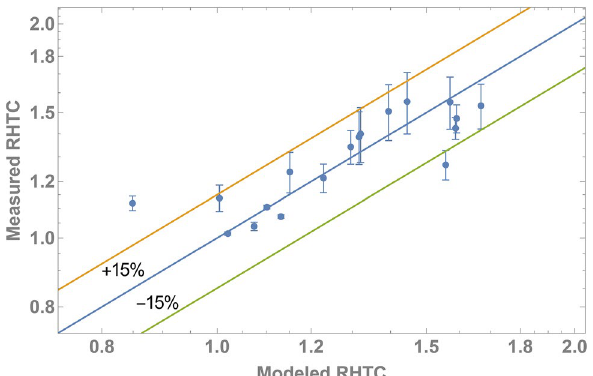
Figure 10. There is good agreement between the measured RTHC (Figs. 6b and 8b) and the modeled RHTC using Eq. (3) for all tested surfactants and concentrations. Our modeled RTHC incorporates the effects of HTC enhancement via adsorption and HTC degradation via viscosity